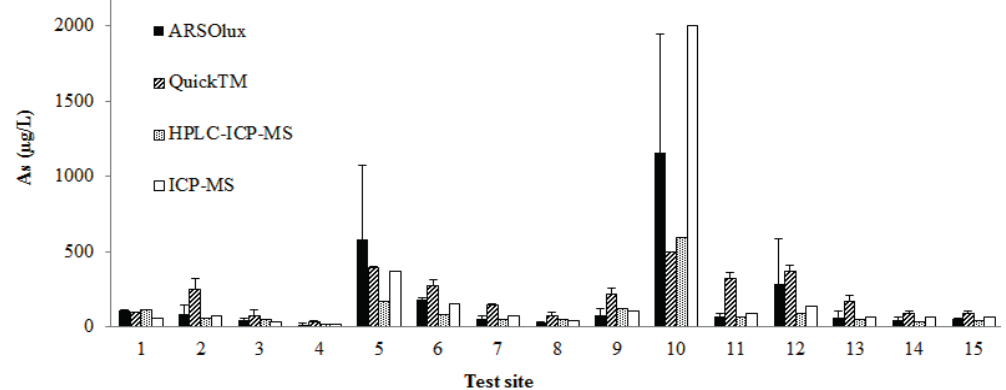
Figure 3. Arsenic concentrations detected with different methods (sample id map Figure 1: 1, 9-Rafaela; 2-Susana; 3,4-San José; 5-Sunchales; 6-Tacural; 7,8-dairy farm near Sunchales; 10-Bella Italia, dairy farm; 11-Bella Italia; 12-Bella Italia cemetery; 13,14-Presidente Roca; 15-School Presidente Roca). Data for ARSOlux and Quick ™ represent means and standard